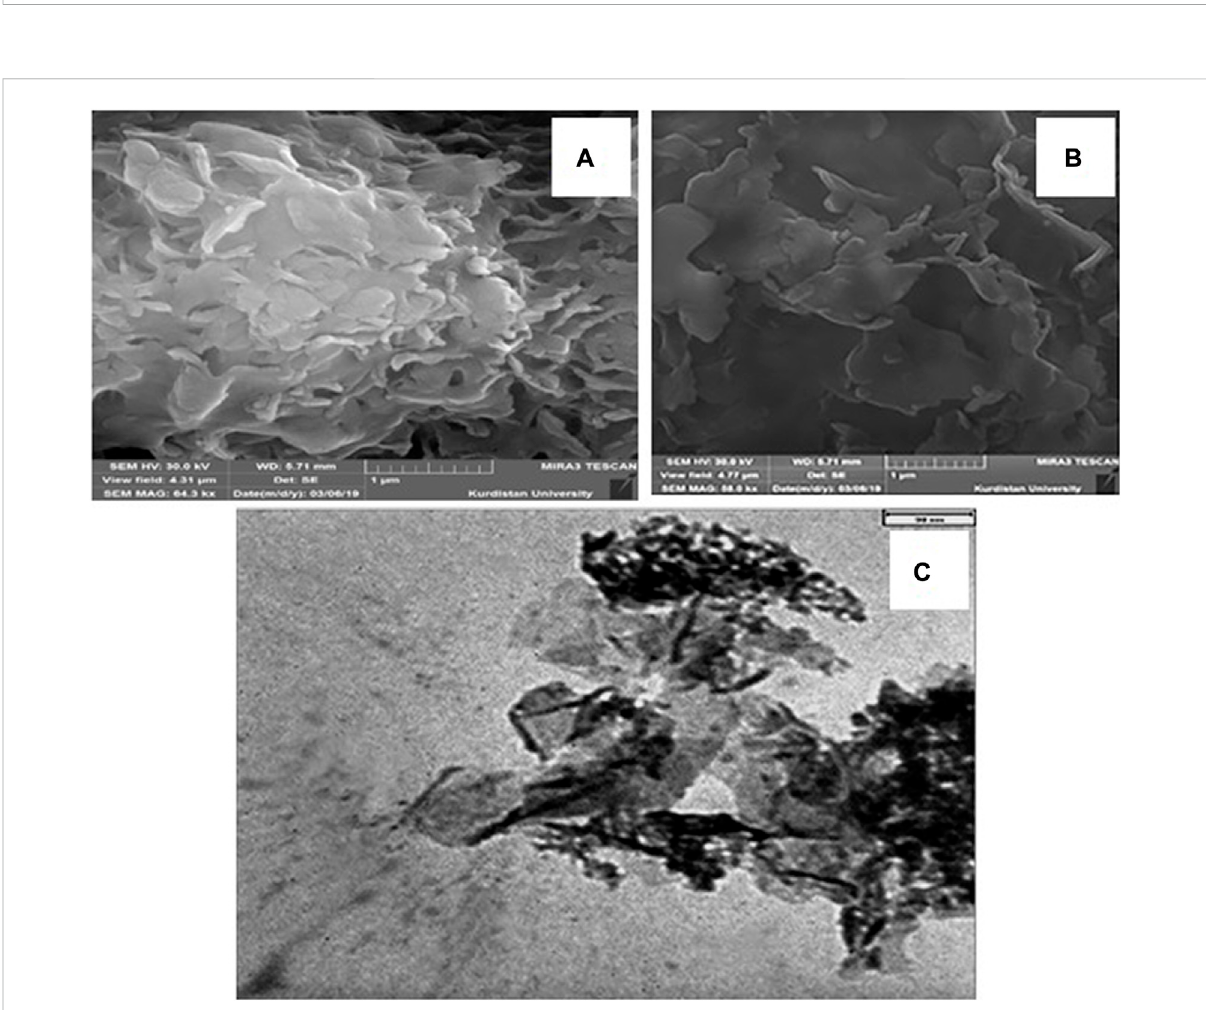
FIGURE 2 SEM micrograph of the Bi 2 O 3 nanostructure by different magni fi cation (A) 64 kx and (B) 58 kx. (C) TEM image of Bi 2 O 3 sample synthesized under optimal conditions of microwave irradiation.